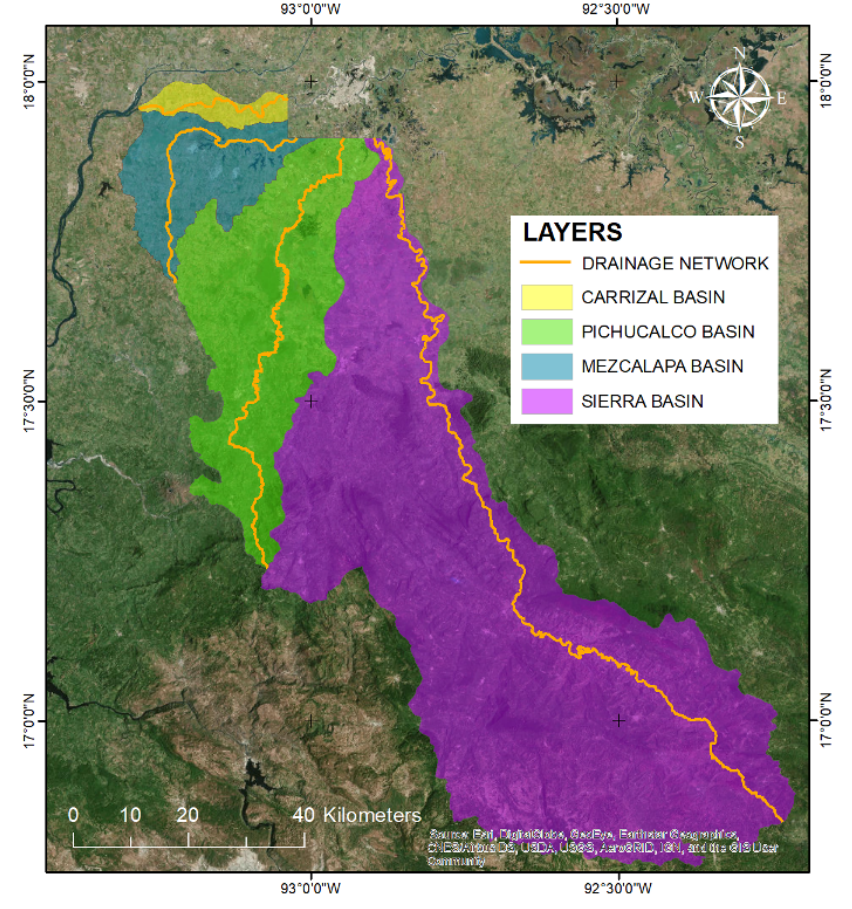
Figure 1. Map of the basins that drain into Villahermosa. Table 1. Hydrological characteristics of the main rivers that drain into